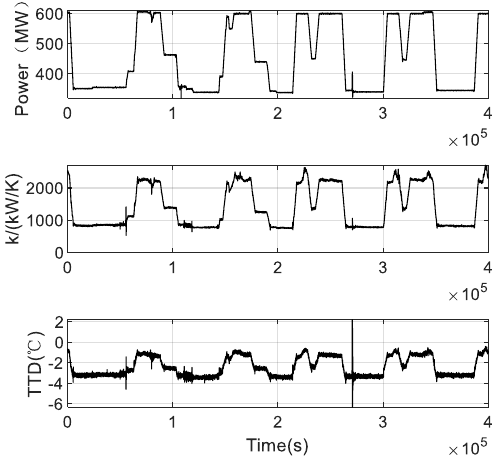
Figure 3. Unit load and corresponding k and TTD.